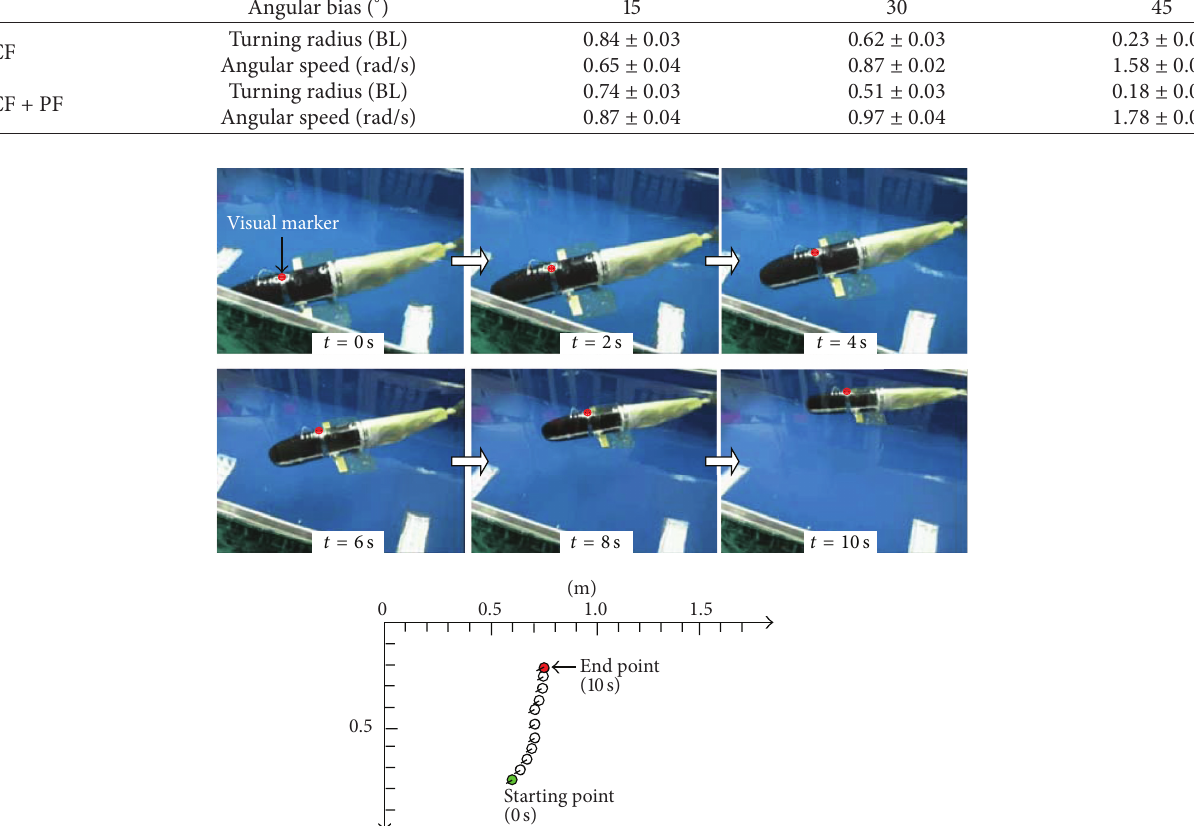
Figure 11: Snapshot sequence and moving trajectory of a sideward swimming gait.